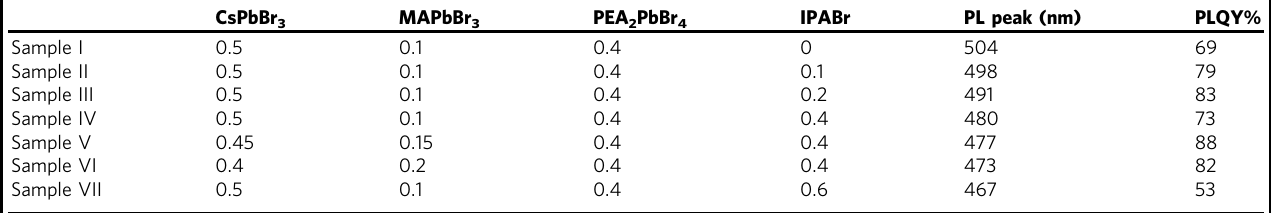
Table 1 Summary of the composition of the perovskite samples and their corresponding PL peaks and PLQY